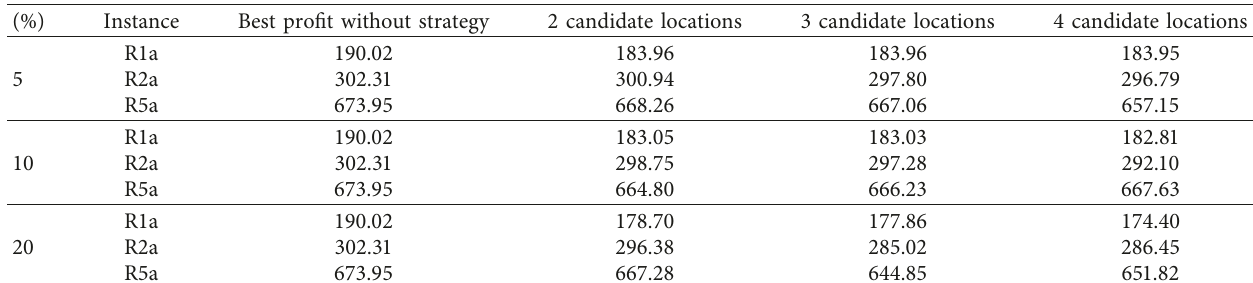
Table 10: Influence of the number of candidate